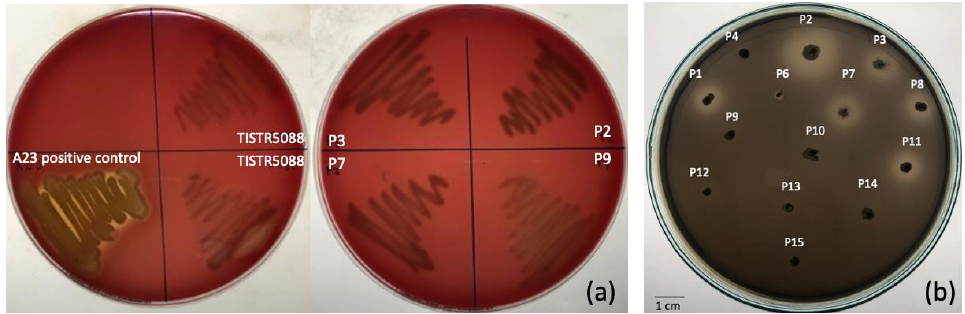
Figure 2. Hemolytic activity of yeast isolates P2, P3, P7 and P9 on blood agar at 30 °C for 7 days ( a